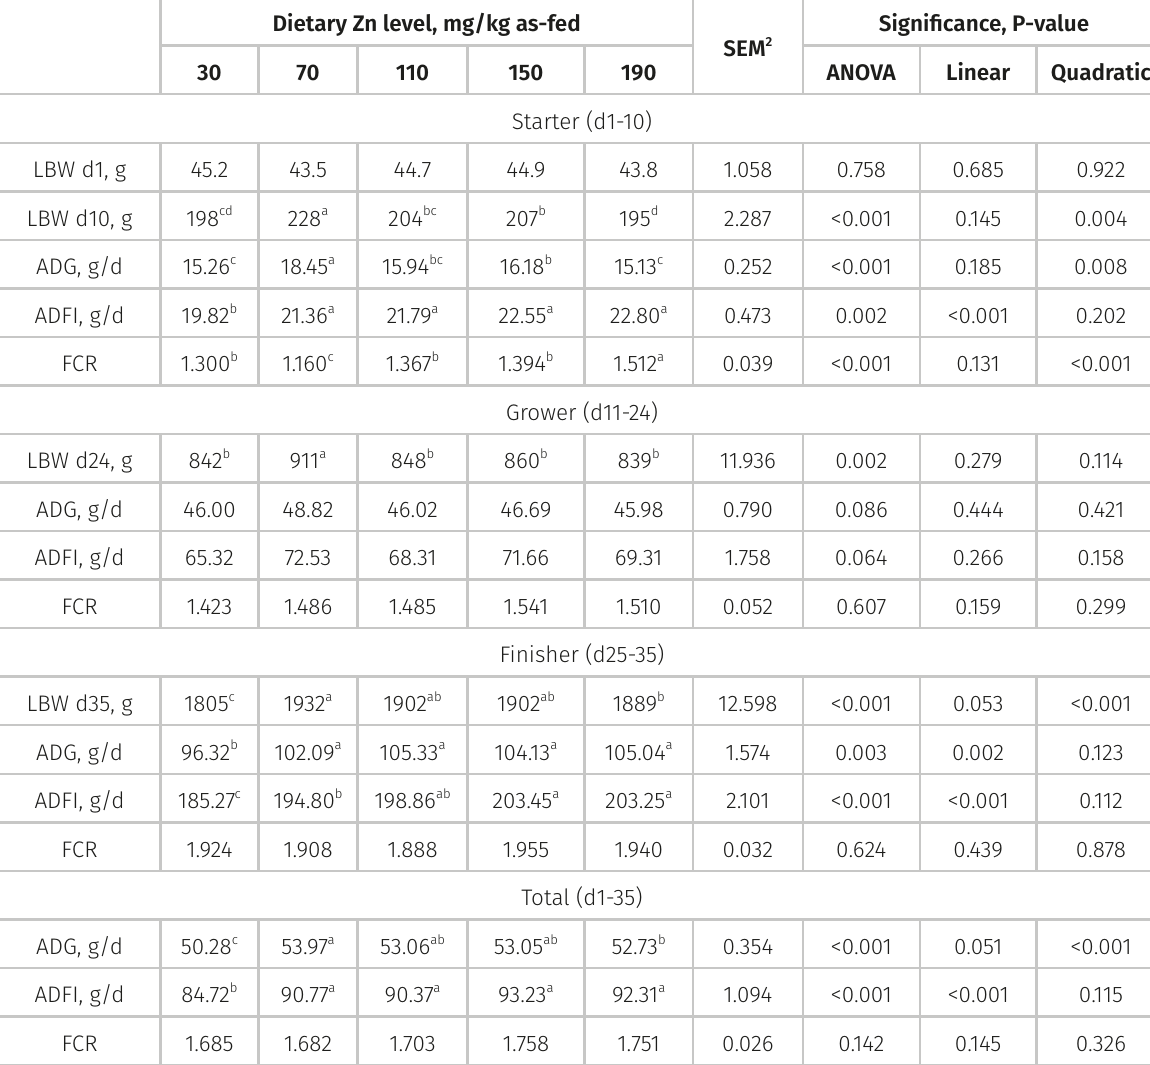
Table III. Effect of dietary zinc concentration on the performance of broiler chickens fed wheat-soy diets 1-35d of age 1